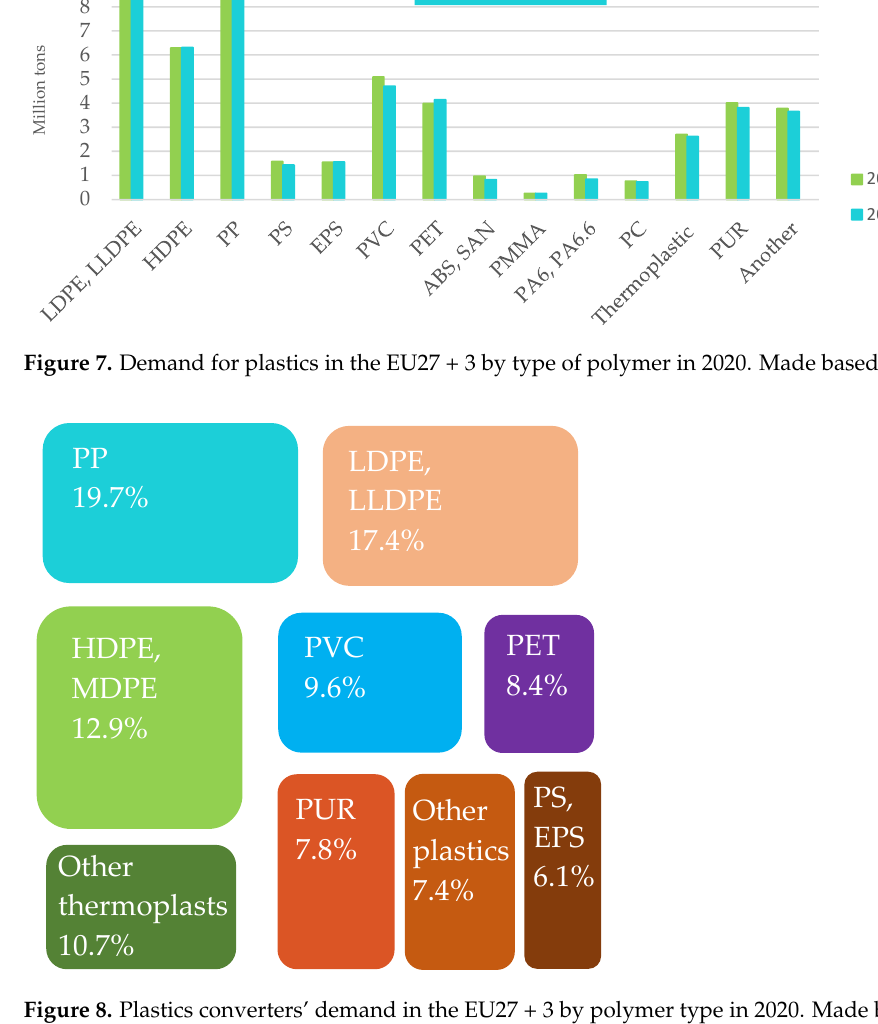
Figure 8. Plastics converters ’ demand in the EU27 + 3 by polymer type in 2020. Made based on [3].